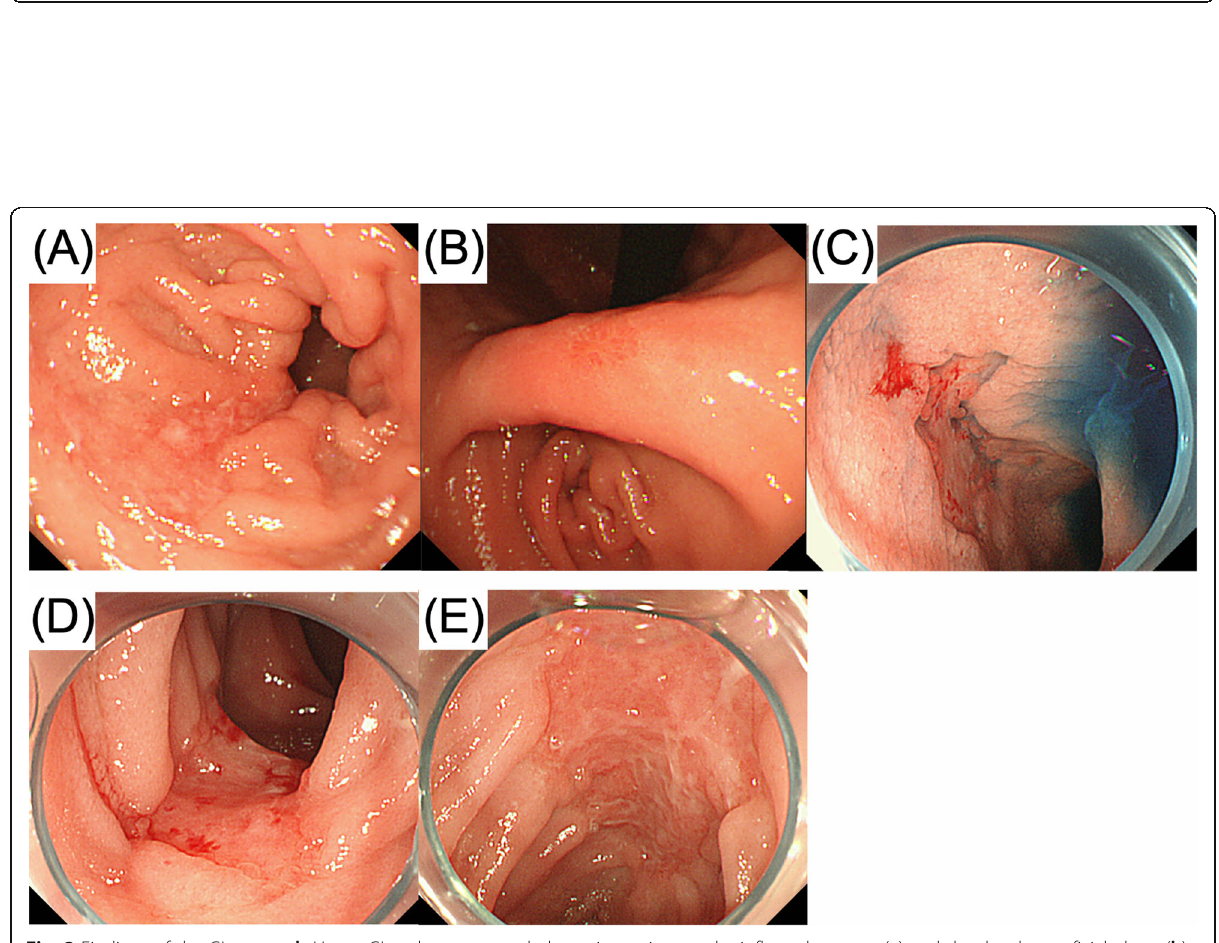
Fig. 3 Findings of the GI tract. a , b Upper GI endoscopy revealed gastric erosions under inflamed mucosa ( a ) and duodenal superficial ulcers ( b ). c – e Colonoscopy with ileoscopy detected multiple ulcers in the terminal